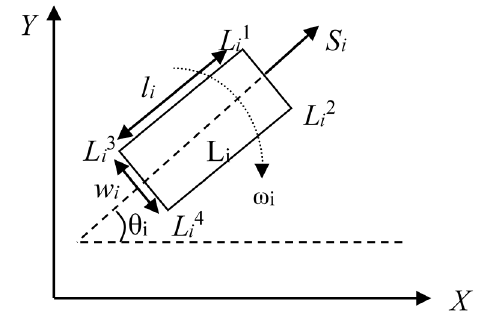
Figure 1. Basic notations of the